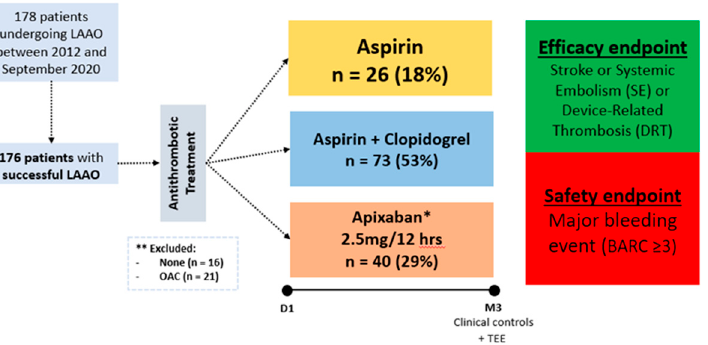
Figure 1. Study Flowchart. January 2012 and September 2020, 139 patients with successful LAAO implantation were included. LAAO, left atrial appendage occlusion; OAC, oral anticoagulation.